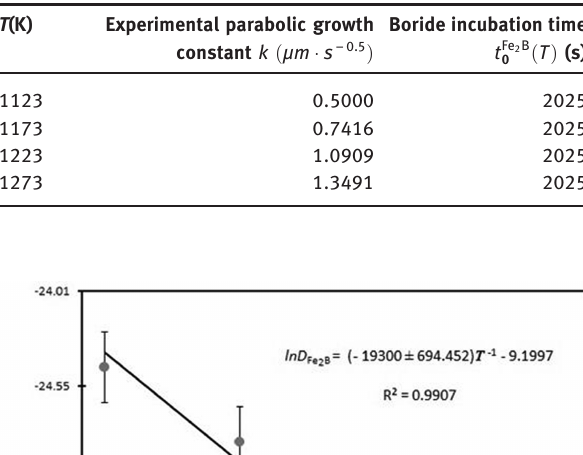
Figure 7: SEM micrograph of Fe 2 B layer formed on AISI 1518 steel at 1253 K for 2 h.